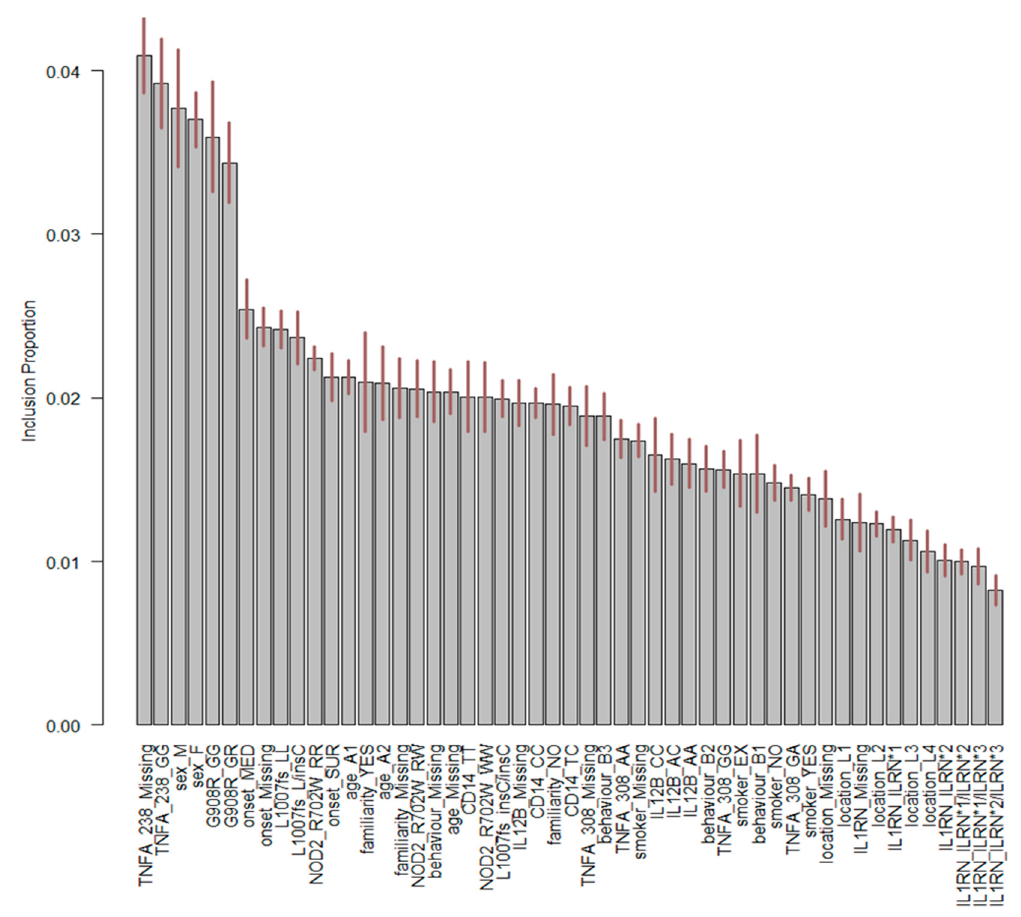
Figure 2. Important variables of BART with genetic factors. On the x-axis, the explanatory variables and their associated levels are shown. The first part of the label refers to the name of the explanatory variable, whereas the second part refers to the label of the classification. Variable labels are reported in Table 1. On the y-axis, the percentage of times for each variable was used to determine a splitting rule.